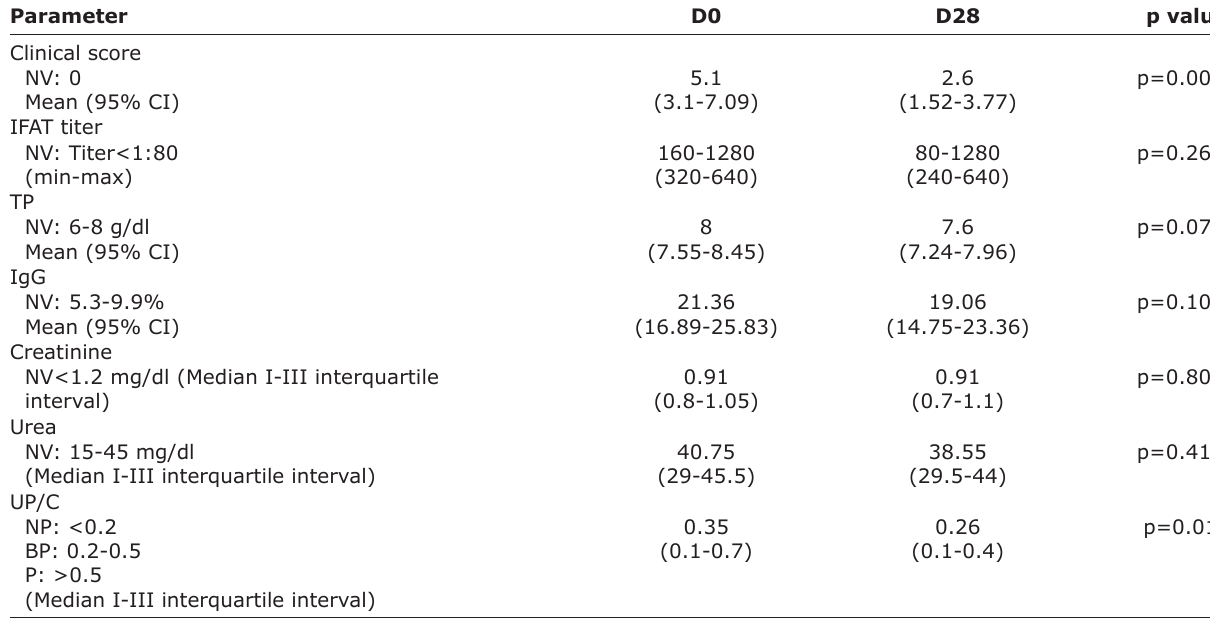
Table-1: Mean, median, 95% CI, interquartile interval and P value of clinical score, IFAT titer, TP (g/dl), IgG (%), creatinine and urea (mg/dl), and UP/C in 20 dogs before and after 28 days of therapy. Parameter Clinical